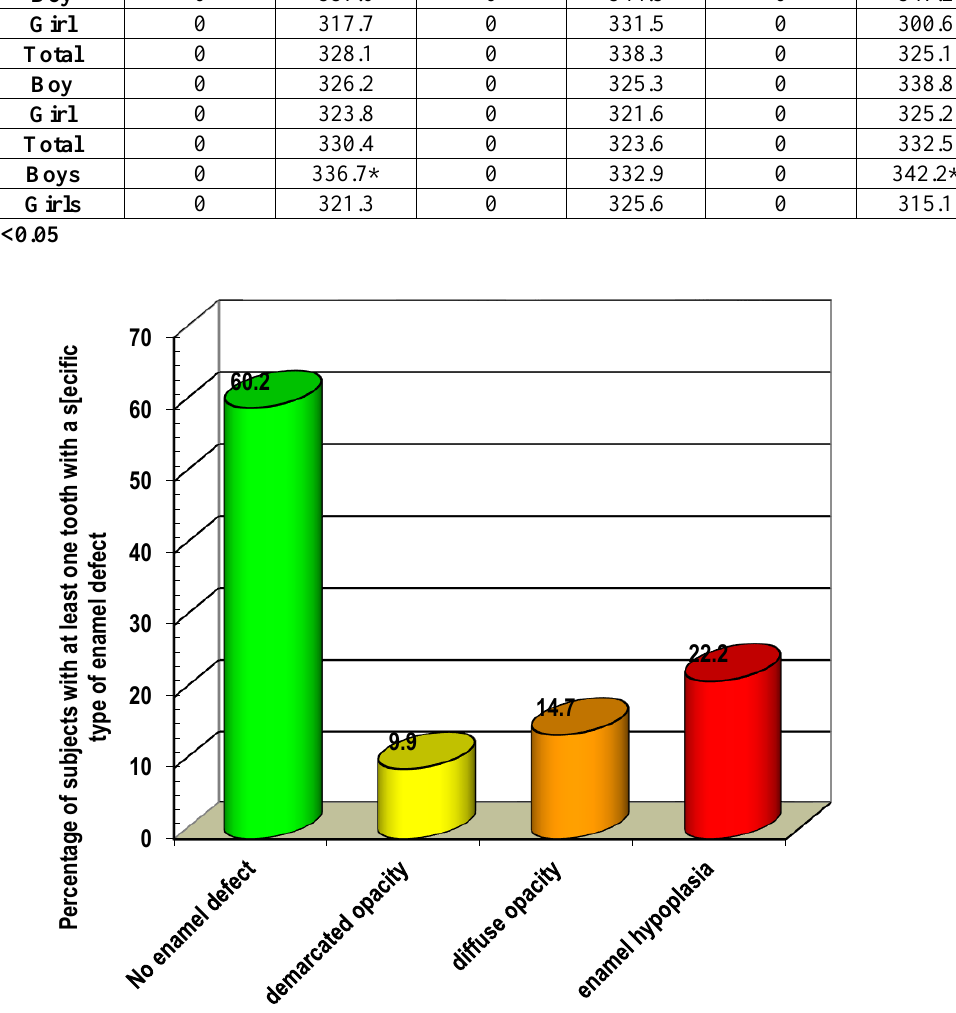
Figure 2: Distribution of the sample according to types of enamel